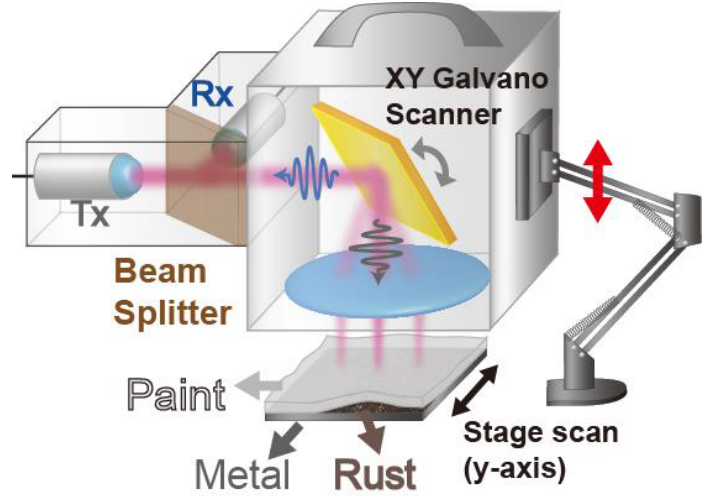
Figure 1. Schematic illustration of the THz-TOF imaging equipment. Tx and Rx denote the THz emitter and receiver, respectively, from the OSCAT THz-TDS system.